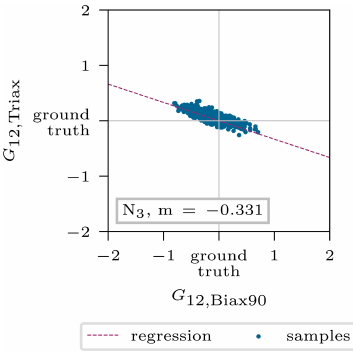
Figure 10. Interaction of density ρ Biax90 and ρ Triax describing the intrinsic model ambiguities. The depicted values correspond to the standardized mean posterior prediction for the 5000 test samples.